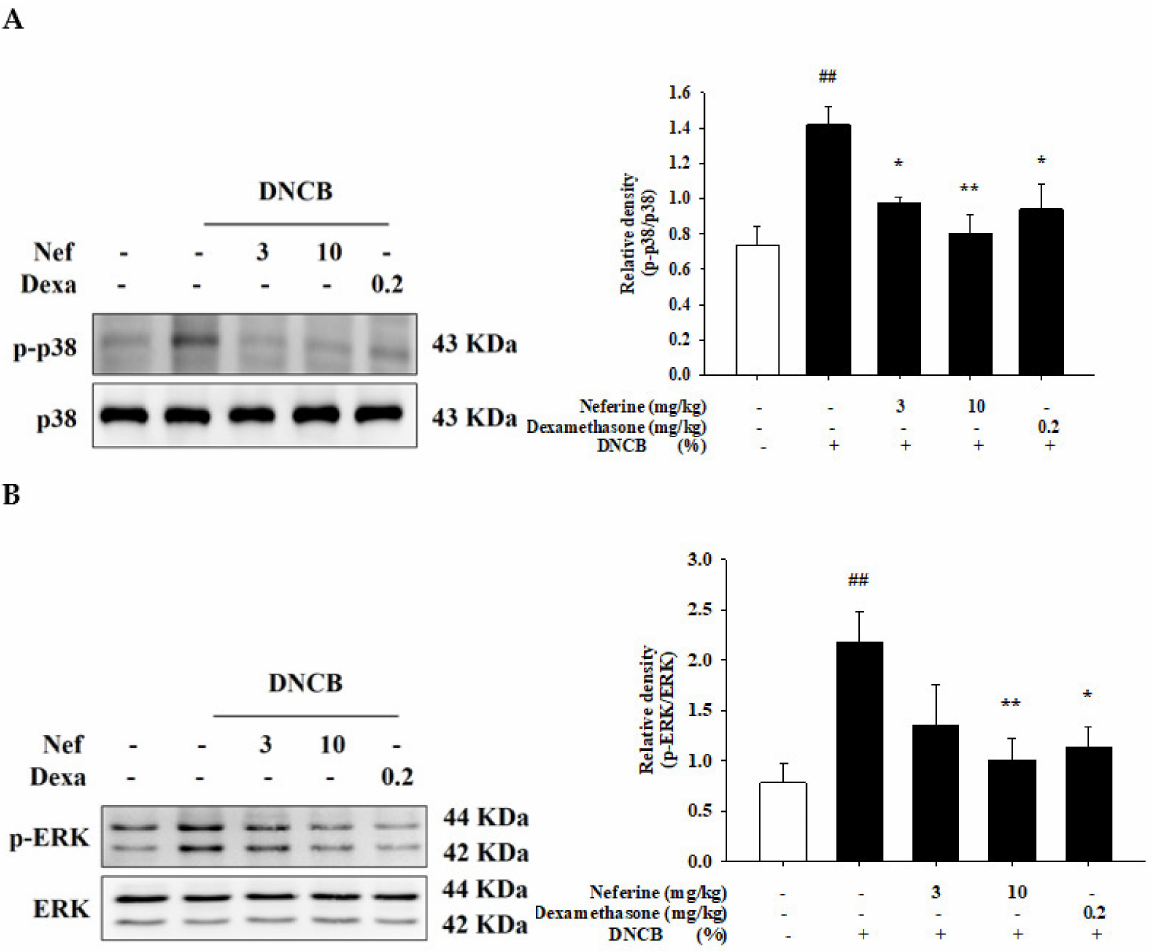
Figure 8. ( A ) Analysis of the effect of the change in the number of scratches in BALB/c mice with an atopic-dermatitis- like phenotype. ( B ) Effect of neferine on the weight of the spleen. Values represent the mean ± SEM from at least six independent experiments. ## p < 0.01 compared with the no-treatment condition; * p < 0.05 and ** p < 0.01 compared with the DNCB-induced